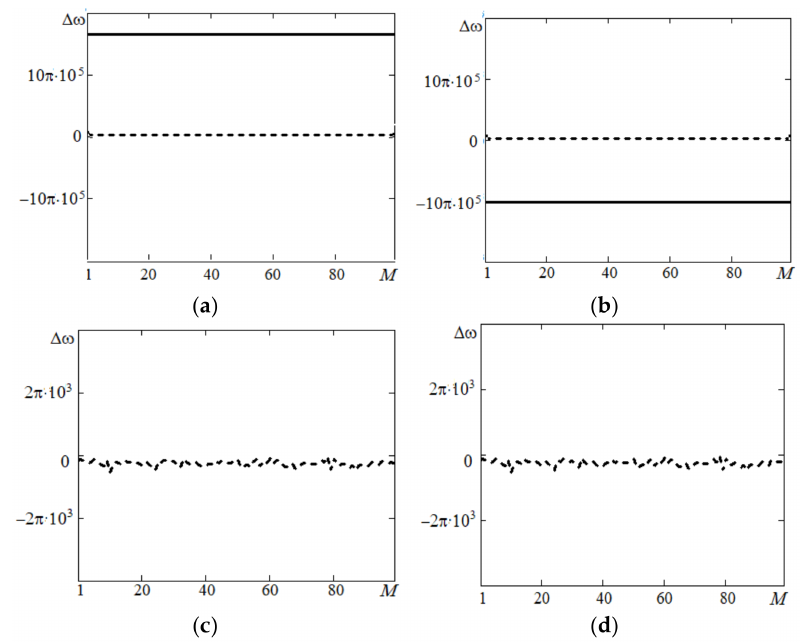
Figure 3. Frequency deviations and frequency deviation estimation error for one of the oscillators in the system for the event N 1 oscillators have ∆ ω n (cid:54) = 0, N 2 oscillators have ∆ ω n = 0: ( a , b ) frequency deviations and frequency deviation estimation error; ( c , d ) oscillator frequency deviation estimation error.